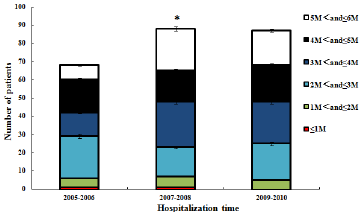
Figure 3. Total numbers of hospitalized patients # 6 months old in different years (P , 0.05).